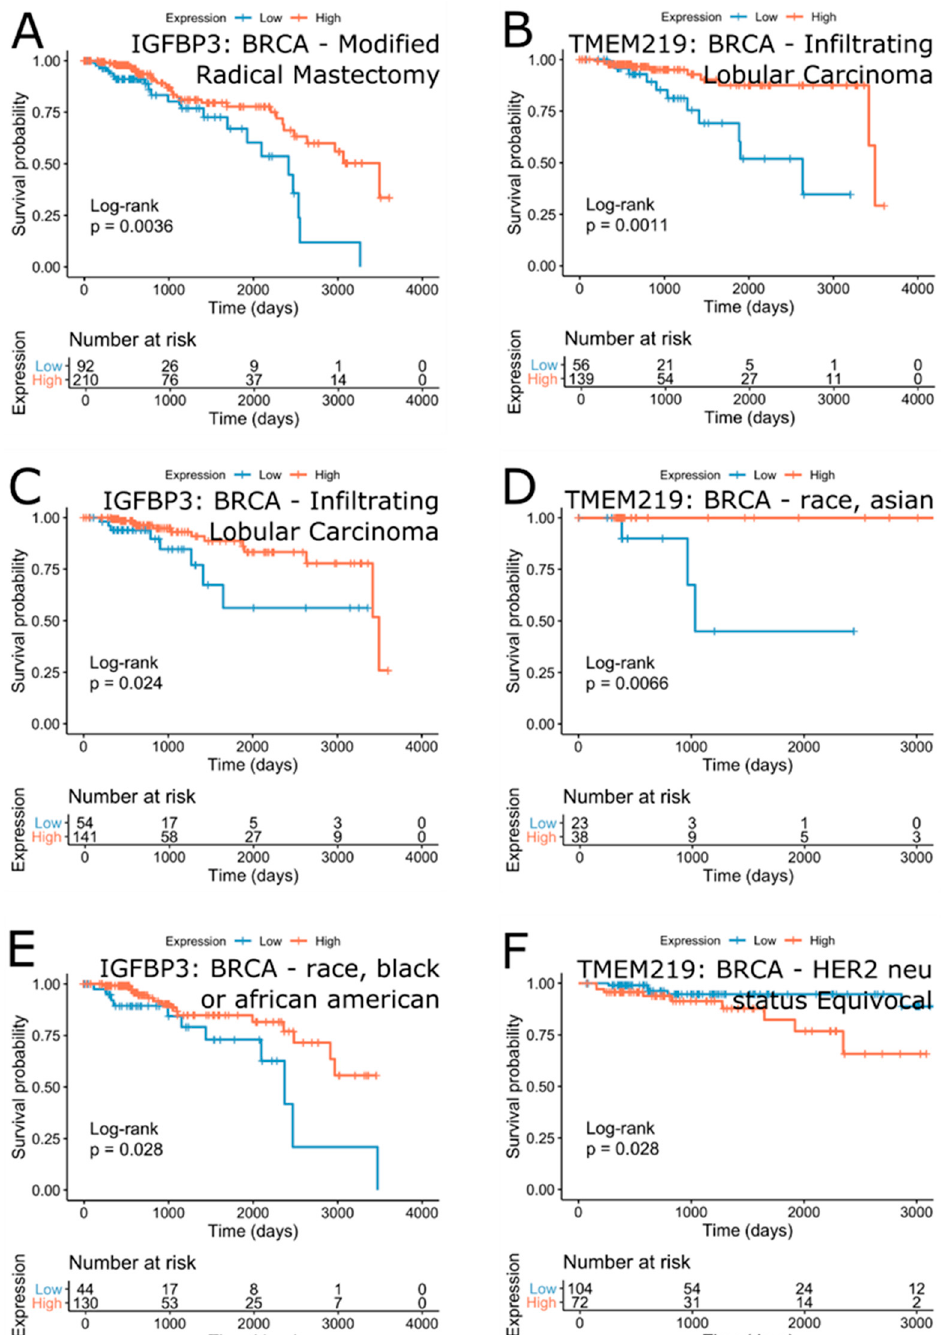
Figure 10. Survival effect of IGFBP-3 ( A , C , E ) and TMEM219 ( B , D , F ) in selected breast cancer subgroups. Unadjusted p -values are